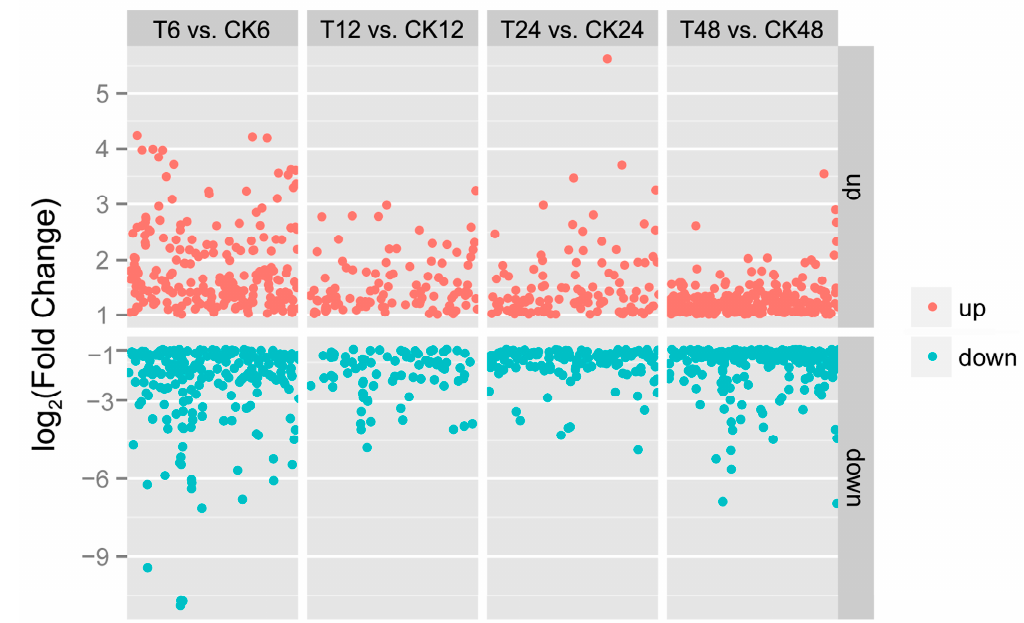
Figure 4. Distribution of the DEGs at different time points after GA 3 treatment in J. curcas . The selected level of the DEGs was |log 2 (Fold Change)| > 1.